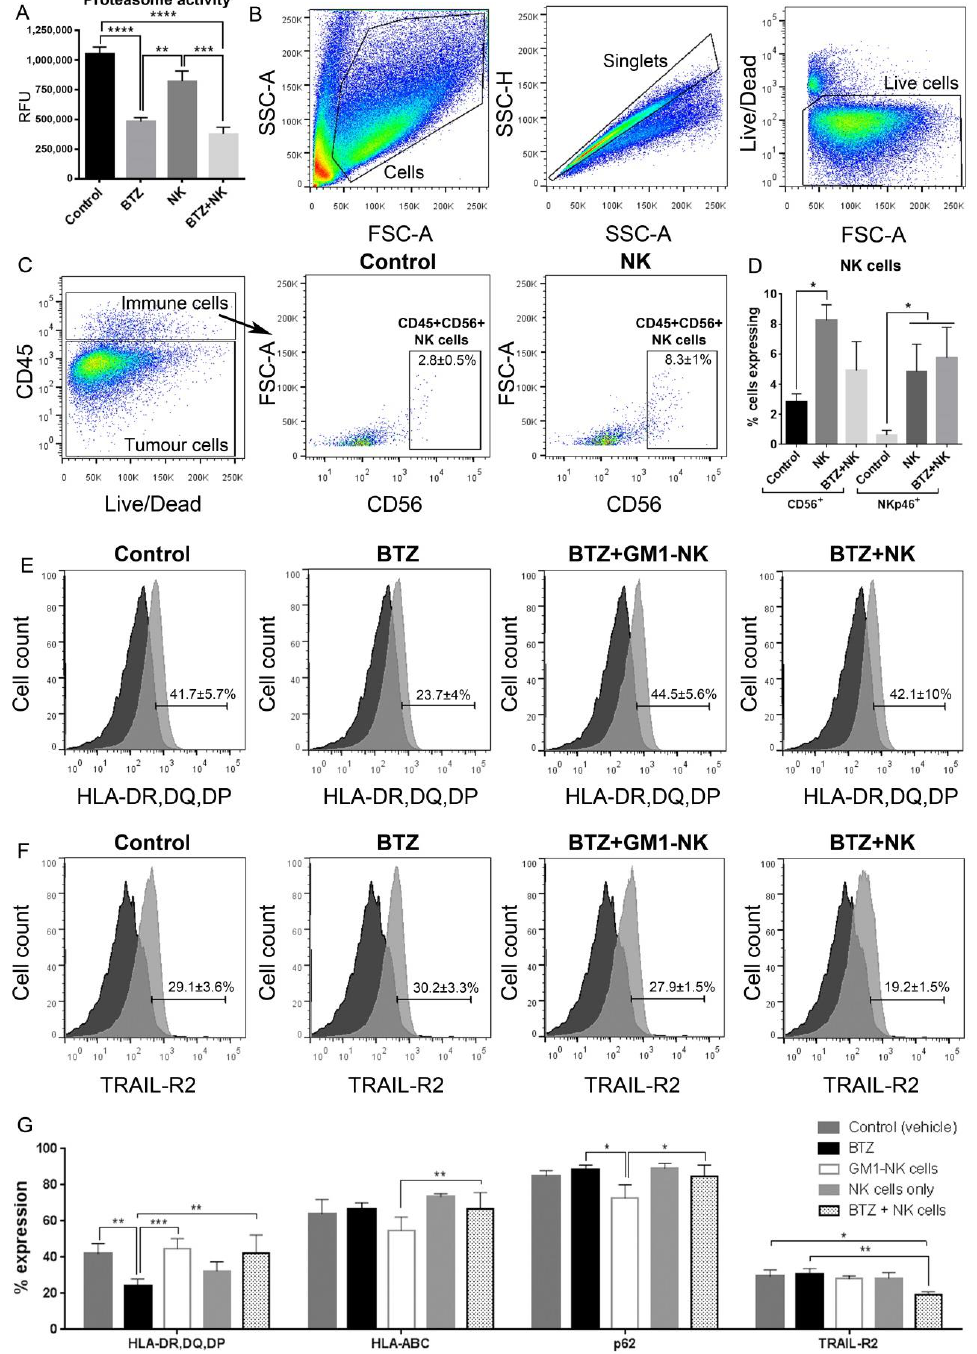
Figure 6. Marker expression of the in vivo experiment. ( A ) Relative fluorescence units (RFU), as a measure of 20S proteasome activity, in dissociated brains from mice from each of the treatment groups indicated. Flow cytometry gating strategy of dissociated tumour-bearing mouse brains (from left to right): ( B ) cells,